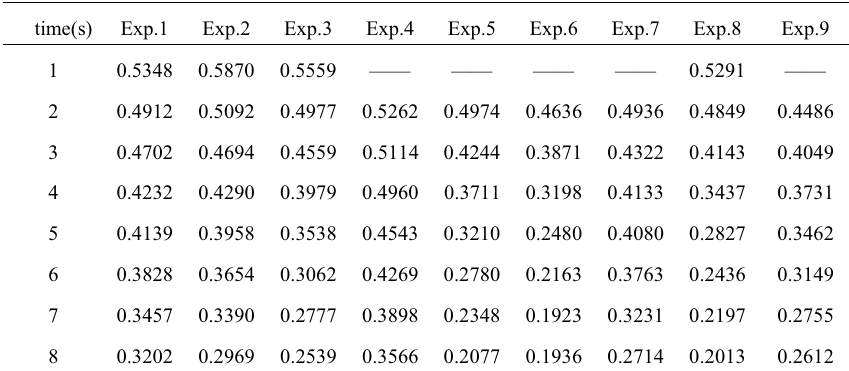
Table 5. The coefficient of